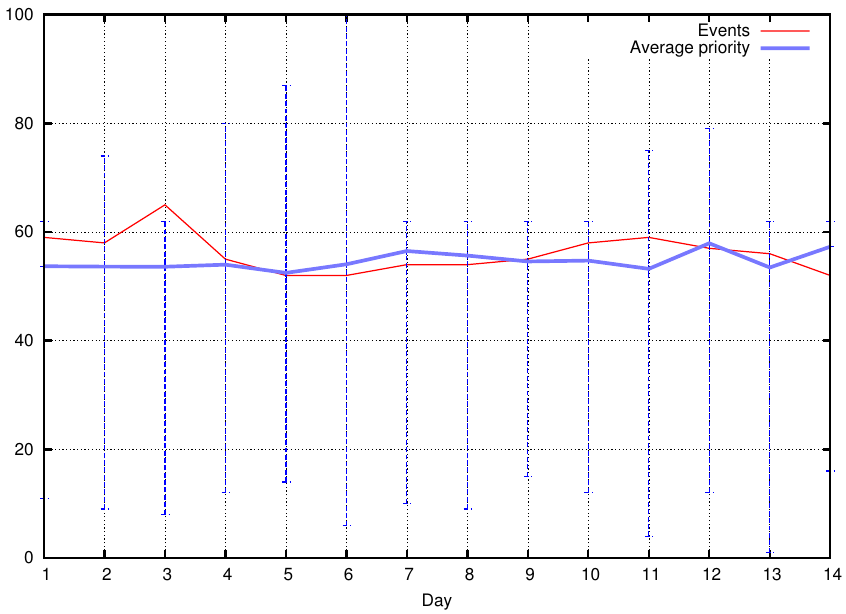
Figure 14. Detected events and average computed